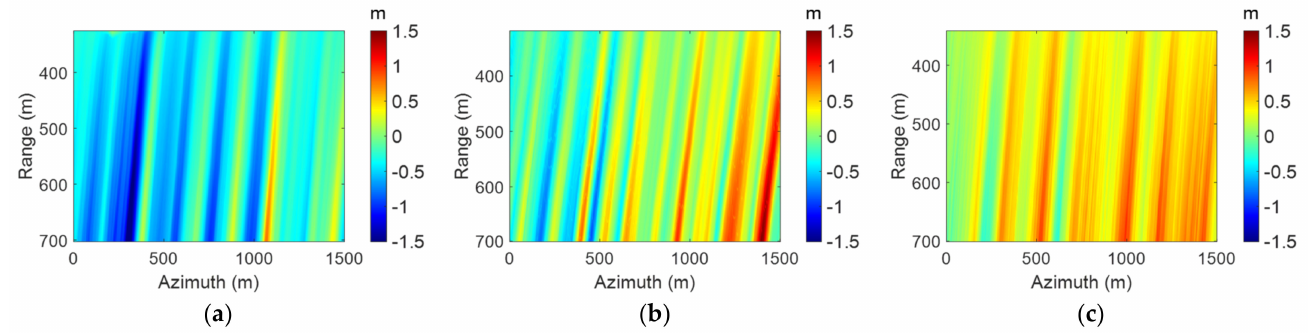
Figure 10. Coupling attitude altimetric errors with correction of position-shifting and resolution unifying of ground distance. ( a ) RZ14. ( b ) RZ16. ( c )